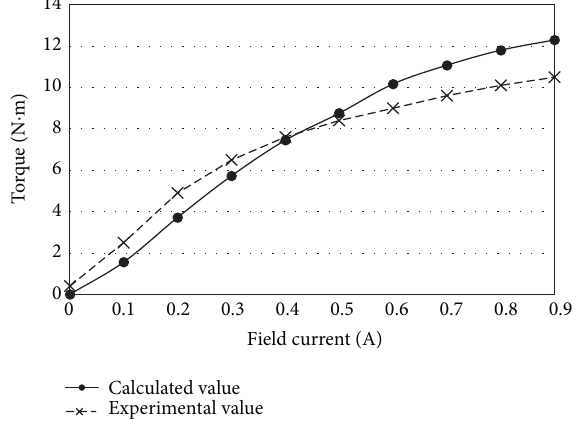
Figure 7: Torque versus field current.